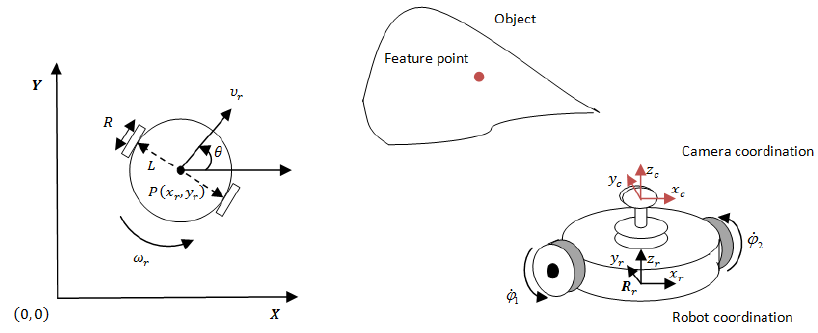
Figure 2. Mobile Robot